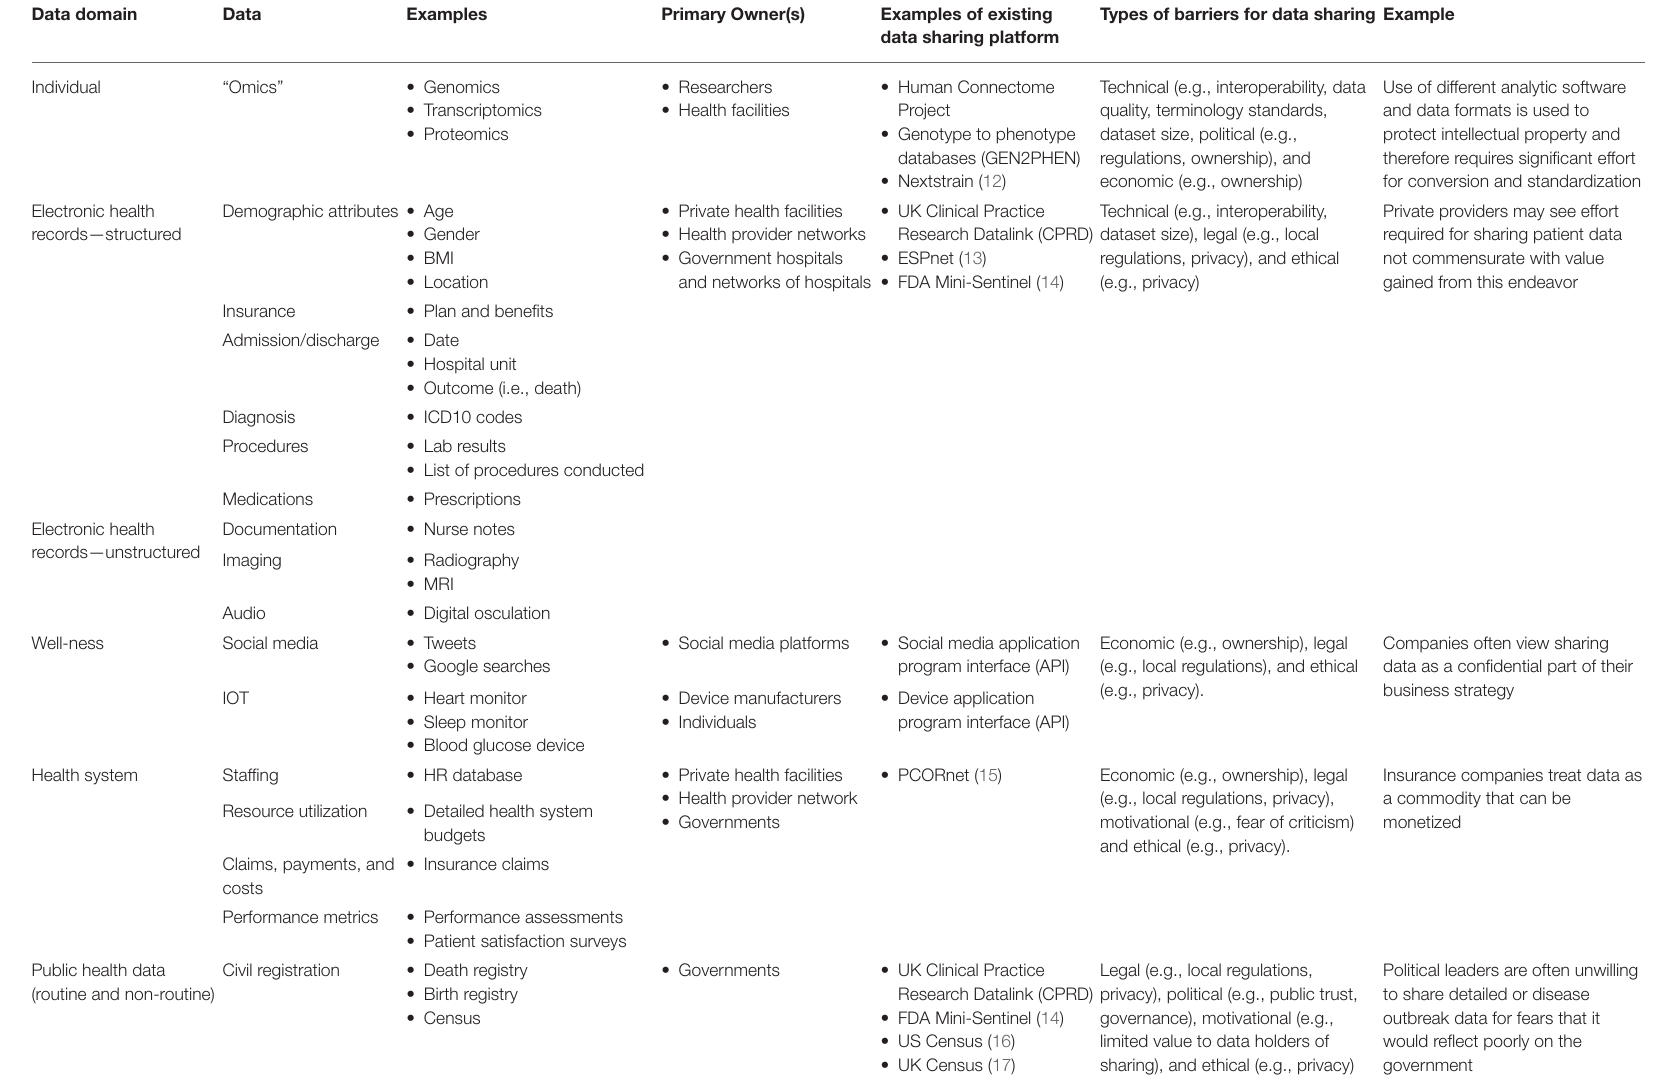
TABLE 1 | Data domains, owners, and examples of data